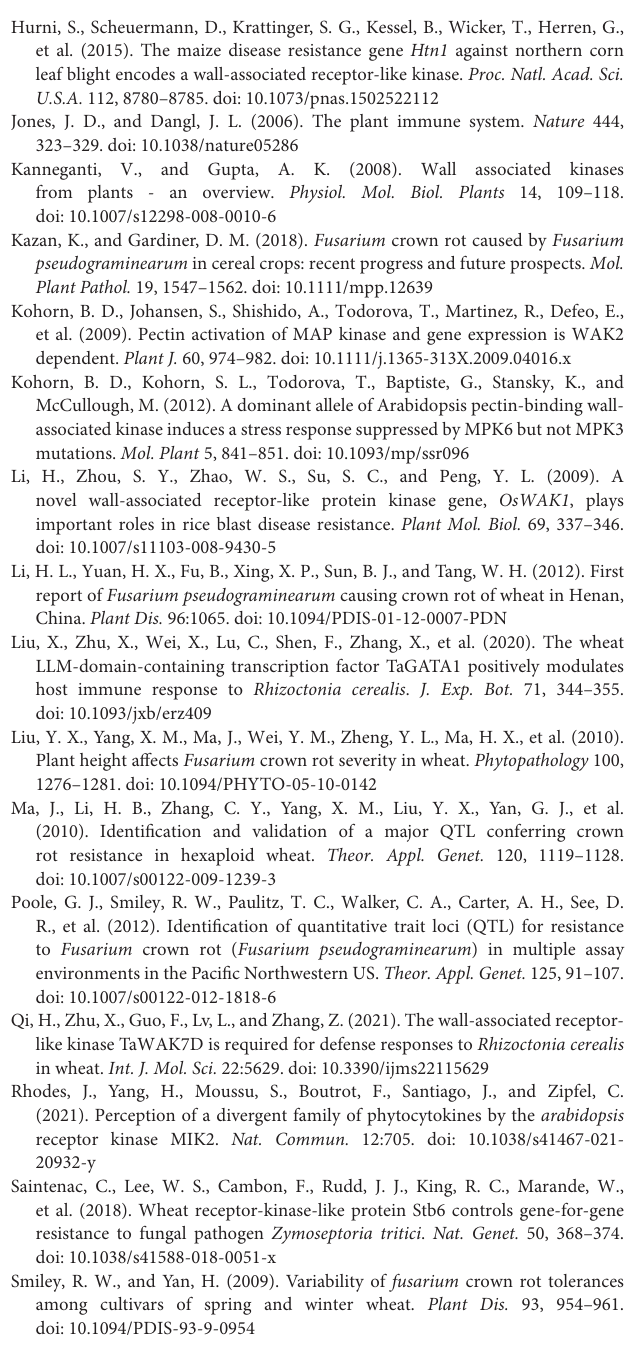
Supplementary Figure 4 | Off-target prediction by si-Fi software and illustration of recombinant BSMV: TaWAK-6D . (A) TaWAK-6D fragment used for BSMV: TaWAK-6D vector construction and selected by an off-target prediction by si-Fi software. (B) Illustration of recombinant BSMV: TaWAK-6D vector. The orientation of the TaWAK-6D insert is indicated by the dark box. Supplementary Figure 5 | Nucleic acid alignment of TaWAK-6D VIGS fragment between TaWAK-6A in the same position.